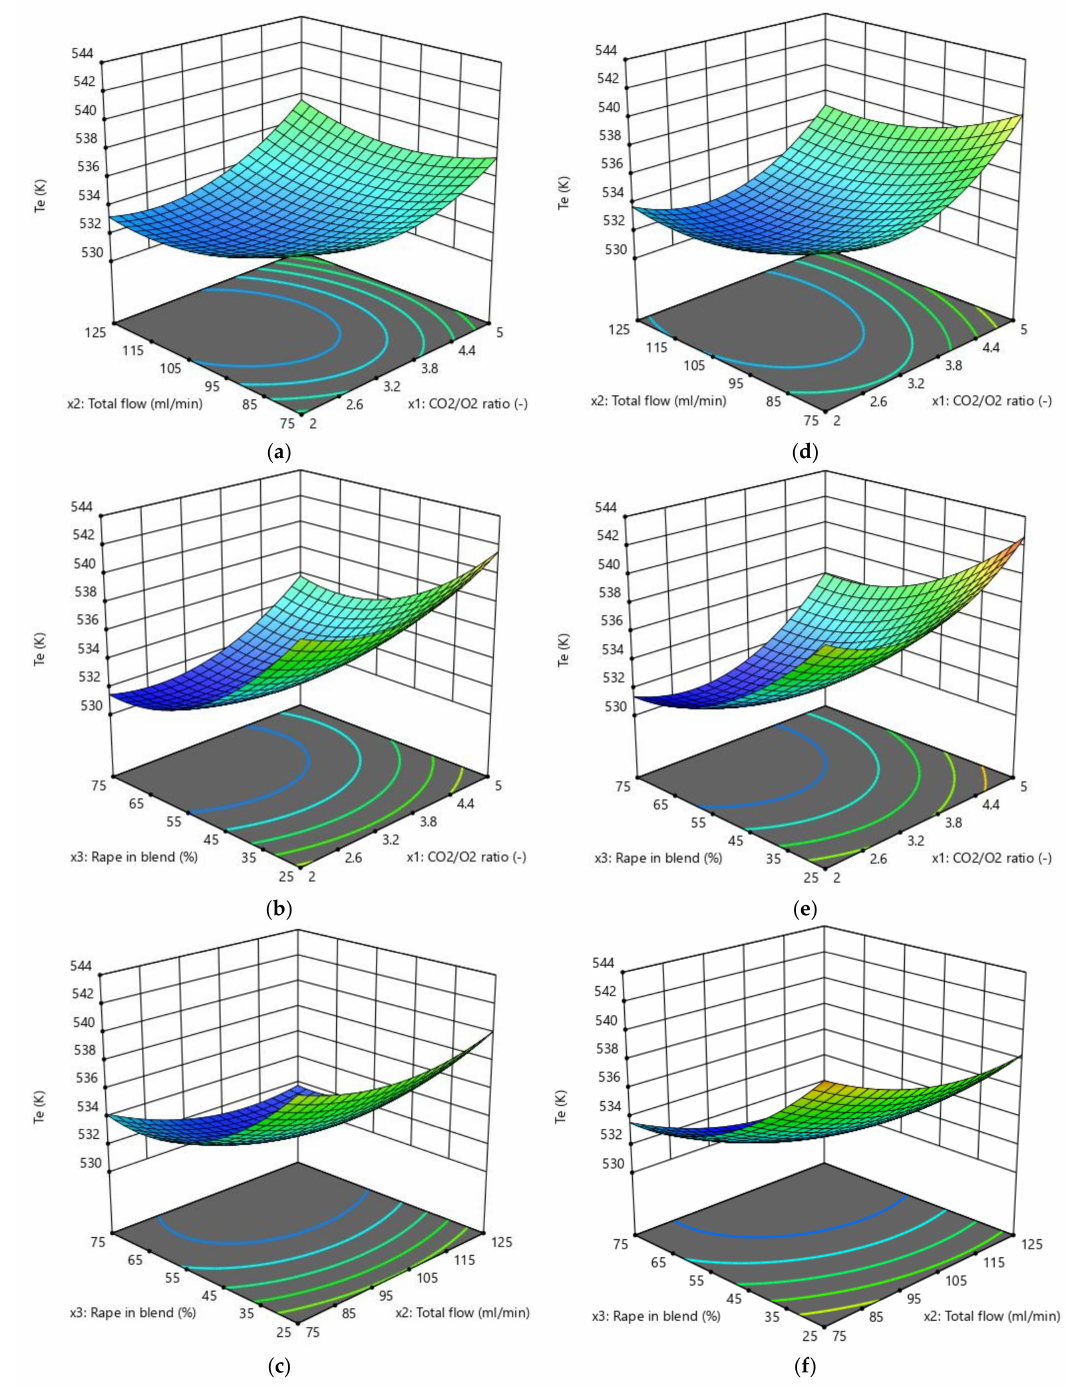
Figure 4. Ignition temperature ( T e ) response surfaces: ( a – c ) Complete design; and ( d – f ) Box–Behnken